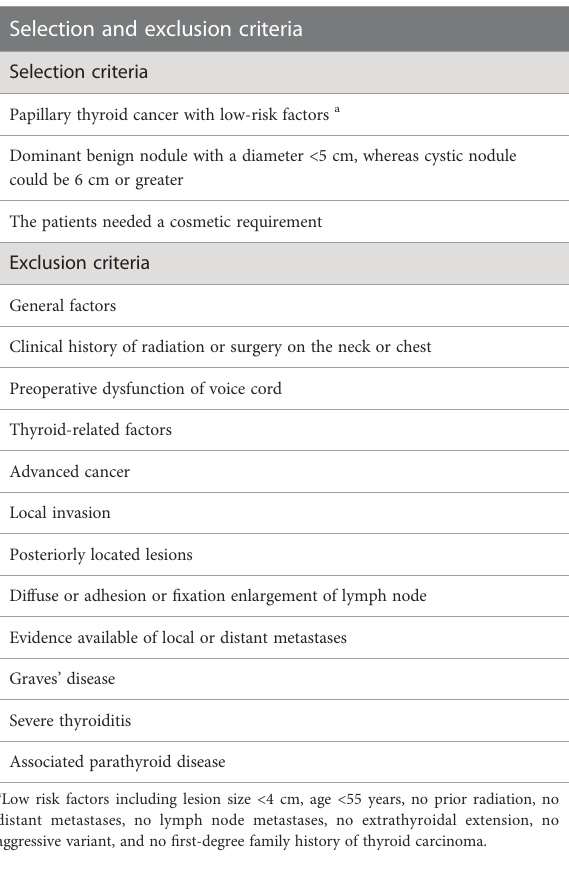
TABLE 1 Detailed inclusion and exclusion criteria for ET and